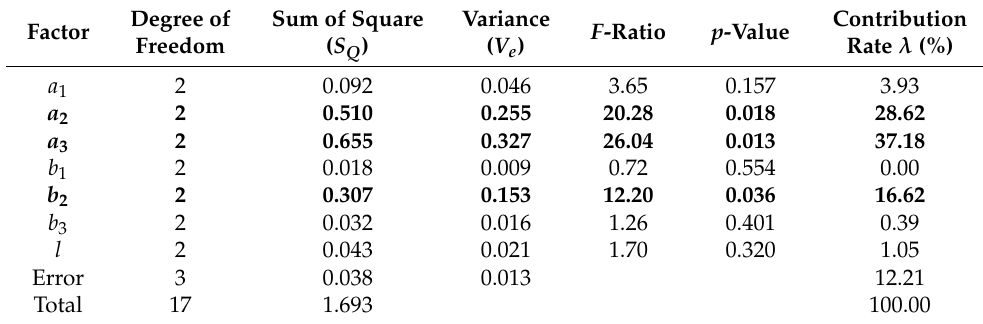
Table 8. ANOVA for 1000 Hz.